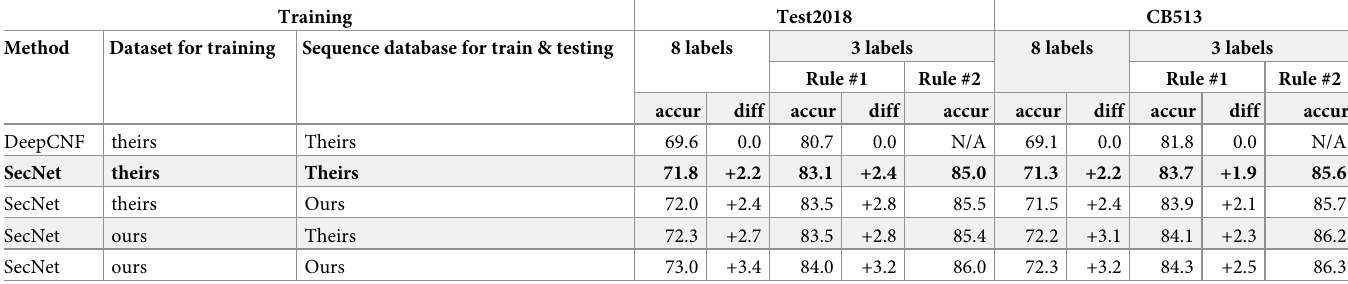
Table 7. Sources of SecNet accuracy improvement as measured on Test2018 and CB513 .